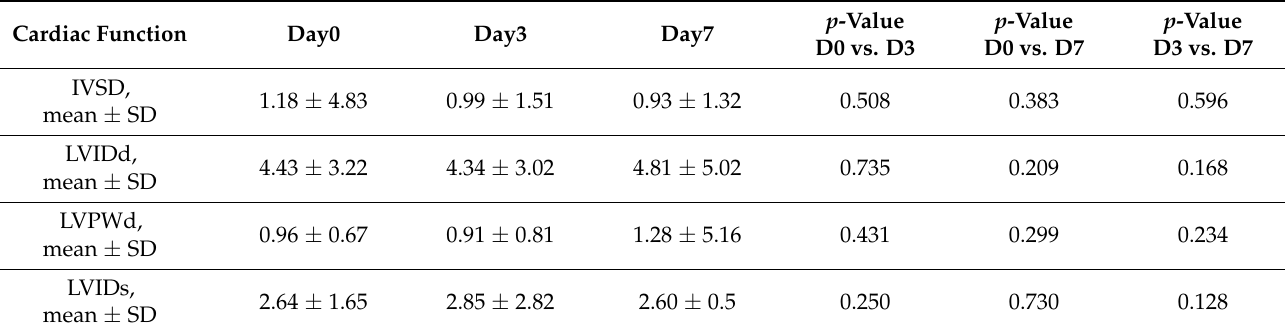
Table 5. Comparison between cardiac function on day of baseline (D0), Day 3 after the second vaccine dose (D3), and Day 7 after the second vaccine dose